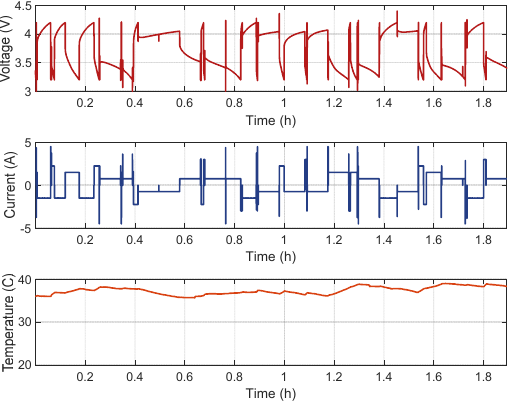
Figure 3. Voltage, current, and temperature of the last 100 steps measured for battery RW9.